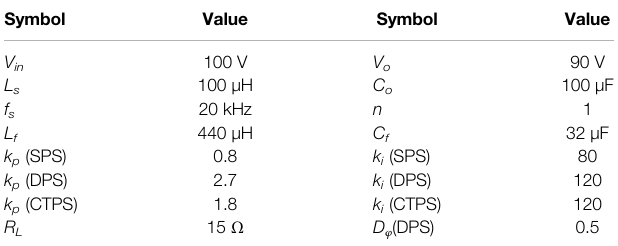
TABLE 2 | Speci fi cations of the DAB converter with LC fi lter.